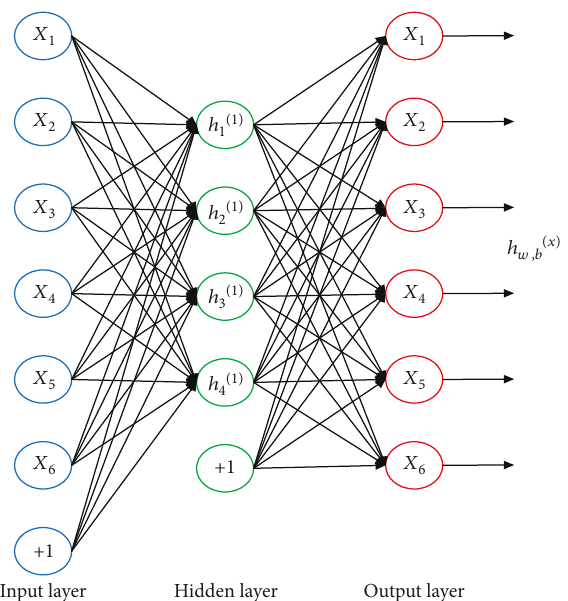
Figure 2: The structure of an autoencoder.